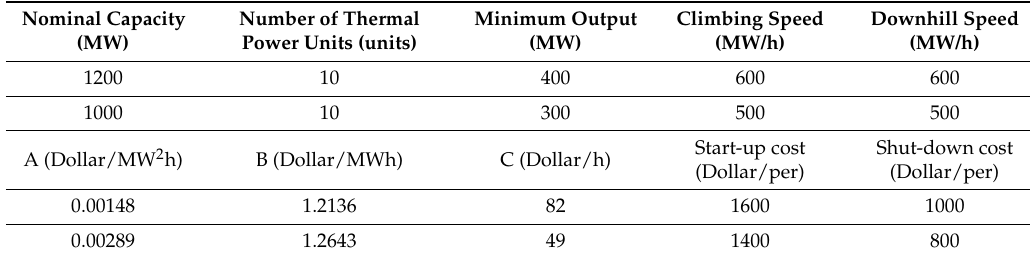
Table 1. Quadratic function A x 2 + B x + C is used to formulate the generation cost of thermal power units. Thus, A, B, and C in Table 1 correspond to the coefficient of generation cost function of each thermal power unit. Table 1. The parameters of thermal power